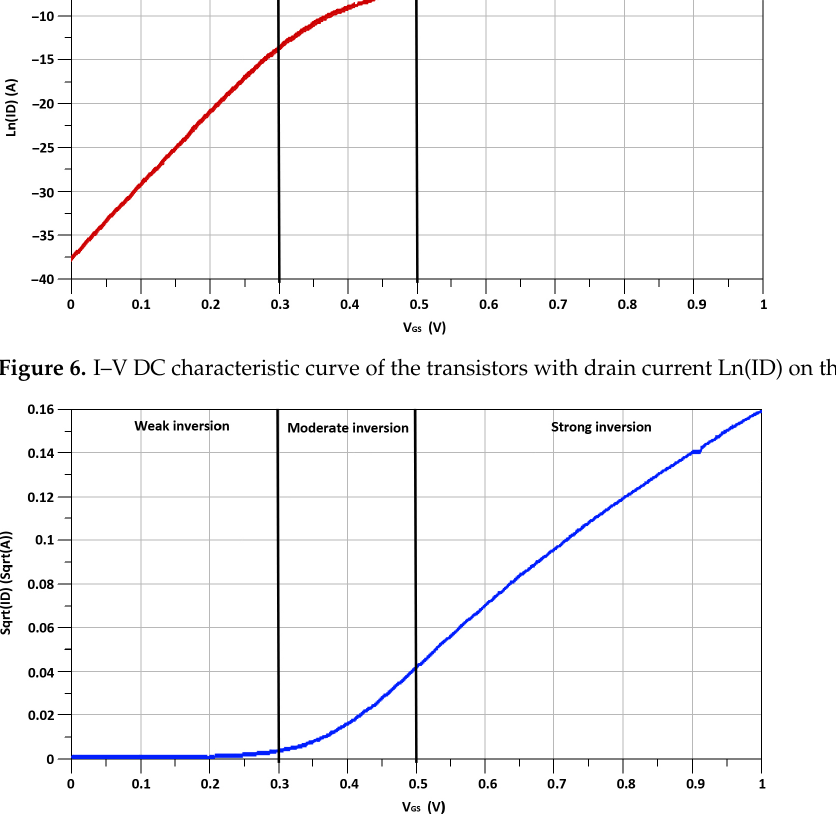
Figure 7. I–V DC characteristic curve of the transistors with drain current sqrt(ID) on the vertical-axis. The small signal model of the transconductance stage of the designed mixer is shown in Figure 8.